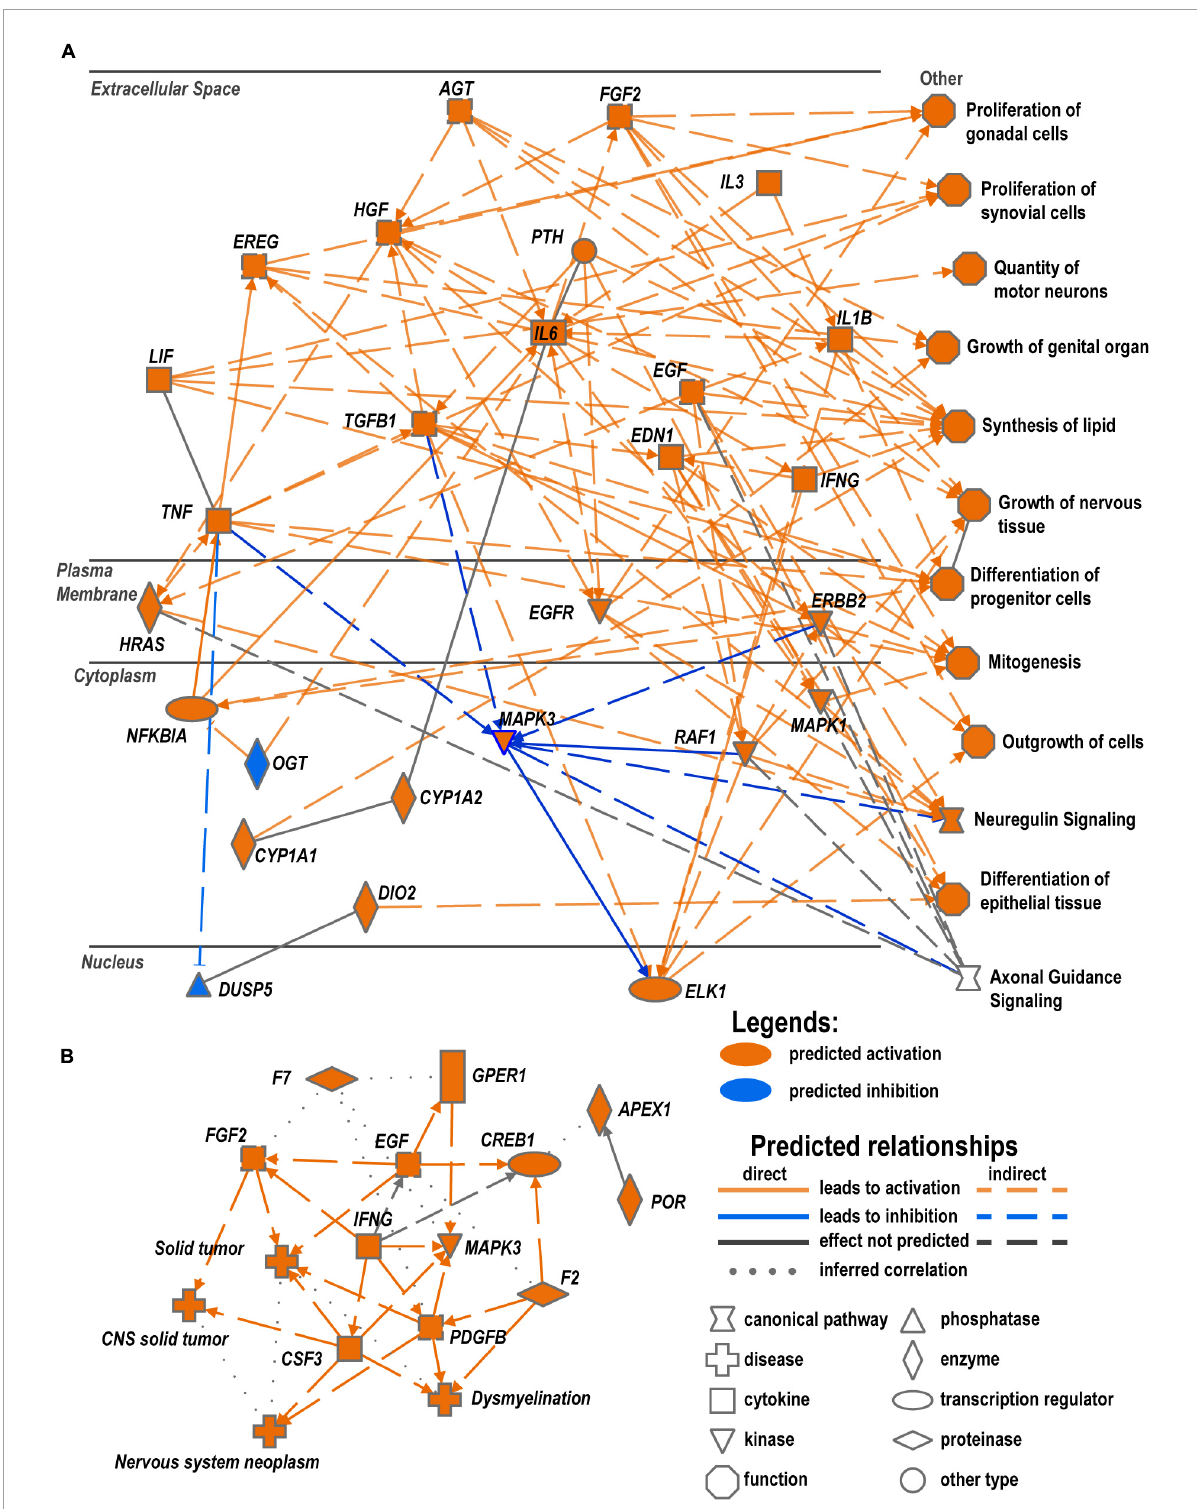
FIGURE8 Crosstalk of cytokines and growth factors could regulate reprogramming in WD. (A) Predicted regulation of male-specific processes based on RNA-seq analysis. (B) Predicted female-specific regulatory network. Networks represent comprehensive synopsis that summarizes the most significant findings in the canonical pathway, upstream regulators, and disease and biological function categories of analysis. Diagrams were constructed in IPA using Graphical Summary function to visualize related biological